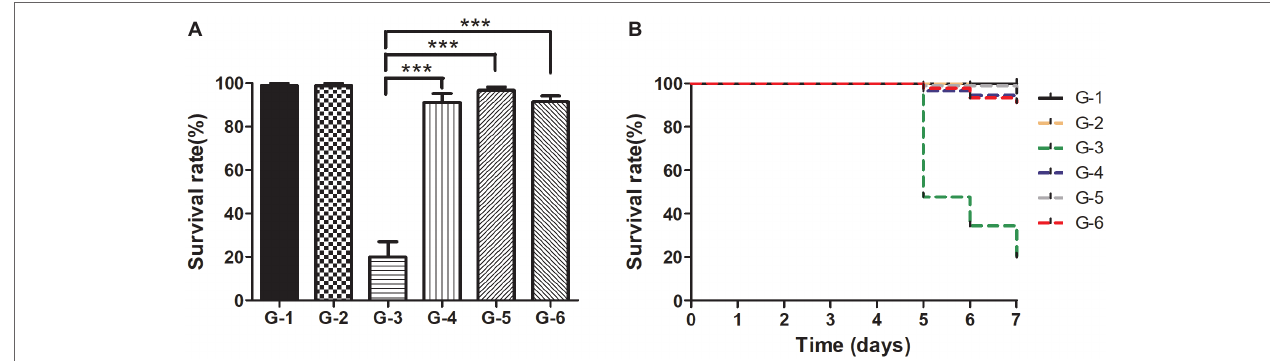
FIGURE 7 | Comparison of the survival rates of the shrimp in different treatment groups in situ . (A) Survival rates of the shrimp of each group after the 7-day treatment; (B) Survival rates of each group in the experiment duration. C: The control group was set up without any treatment. G-1: Group I was given fresh 2,216 medium only. G-2: Group II was challenged with Vibrio sp. Va-F3 at concentration of 2 × 10 6 CFU/ml. G-3: Group III was treated with 10 mg/l kanamycin after two- day challenge of Va-F3 at 2 × 10 6 CFU/ml. G-4: Group IV received treatment of the phage cocktail at the final concentration of 2 × 10 7 PFU/ml. G-5 Group V received treatment of the phage cocktail at the final concentration of 2 × 10 7 PFU/ml after two-day challenge of strain Va-F3 at 2 × 10 6 CFU/ml. Asterisks above the columns indicate significant differences at the p < 0.01 level (Wilcoxon-Mann-Whitney